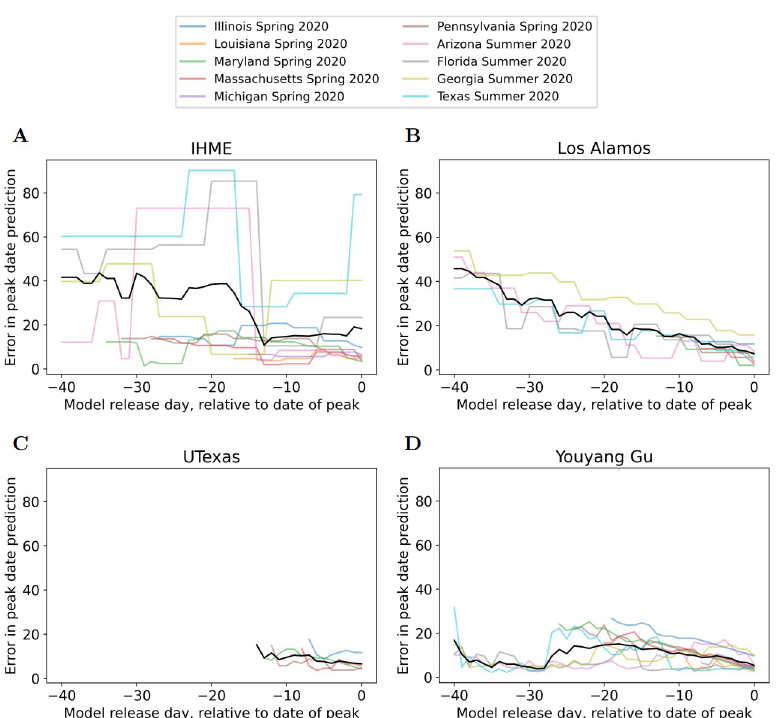
Fig 5. Errors in prediction of date of peak deaths. A) IHME, B) Los Alamos, C) UTexas, and D) YYG. Colored lines represent different peak events, black line is average across peak events. Lines that begin later than -40 begin on date of first model release. If the model did not predict a peak would occur the error is undefined so no line is